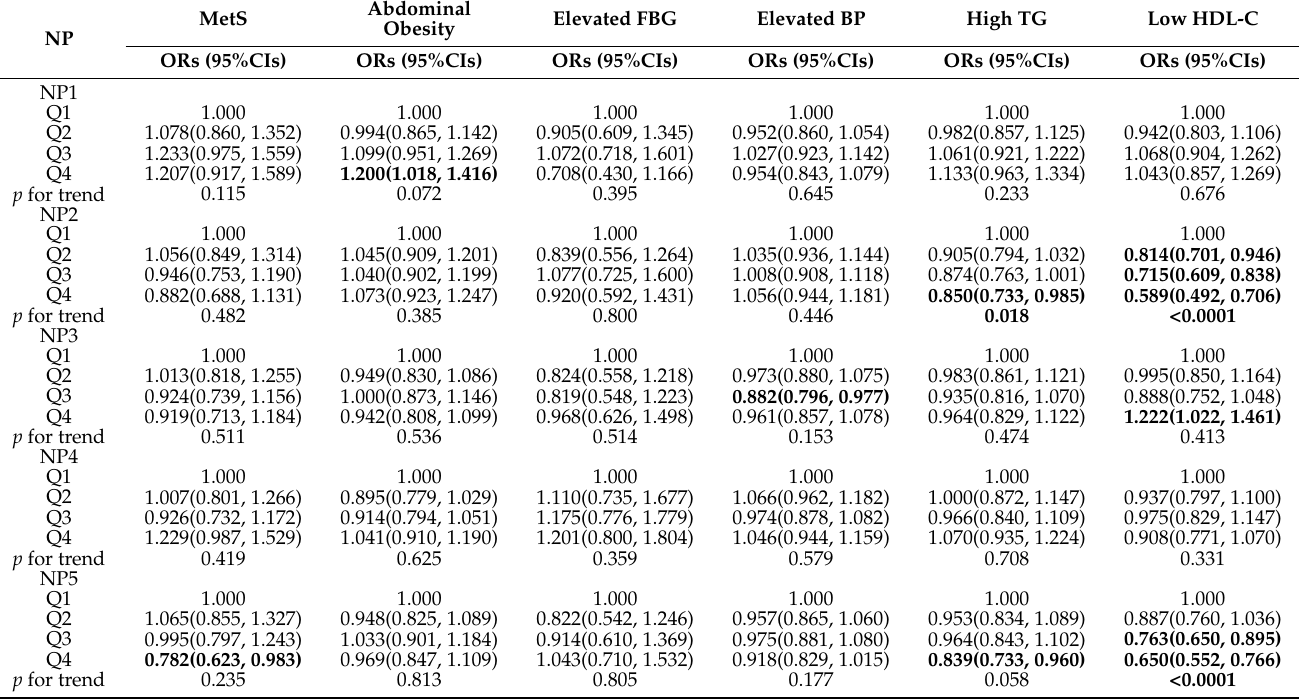
Table 3. The associations between nutrient patterns with MetS and its